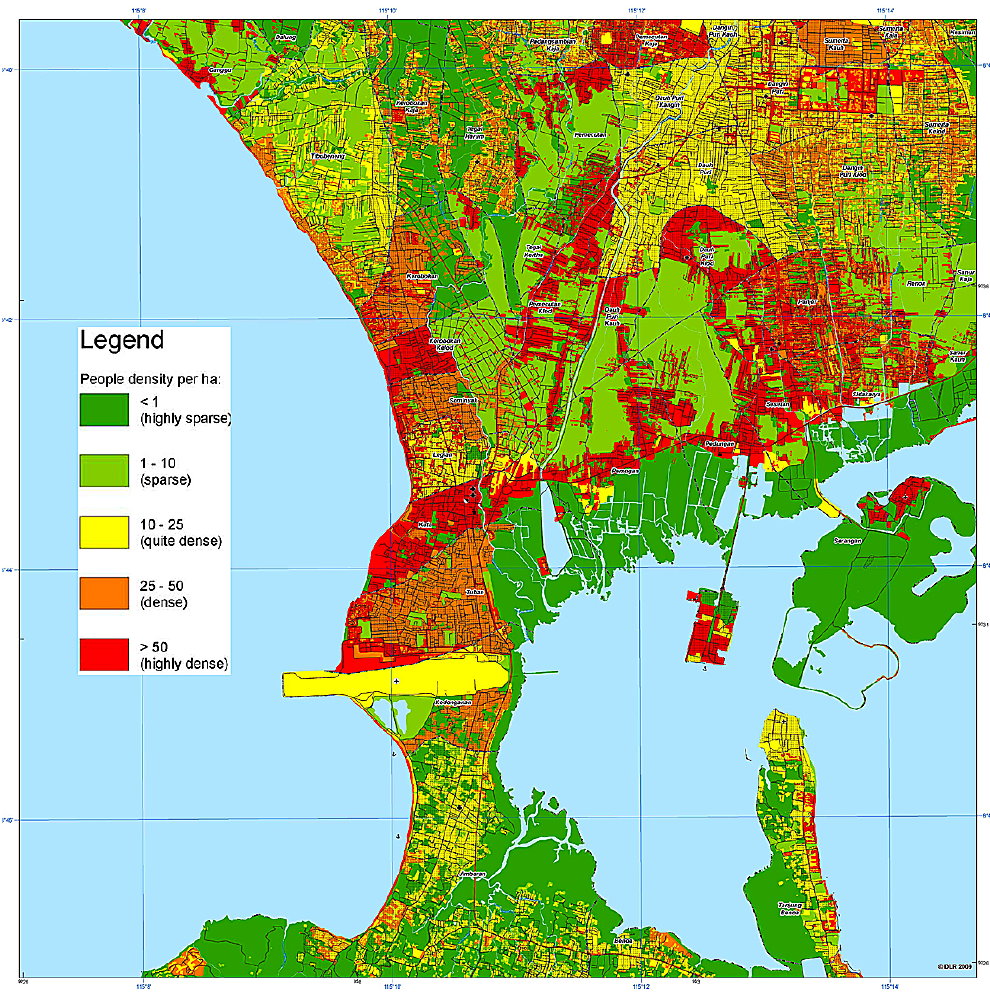
Fig. 11. Population exposure map of Kuta